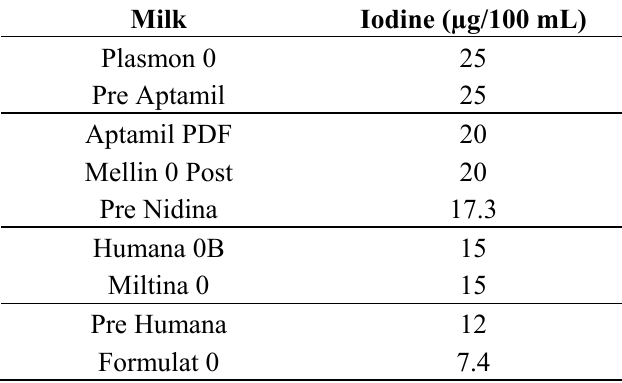
Table 3. Some of commonly used Preterm Infant Formulas: iodine